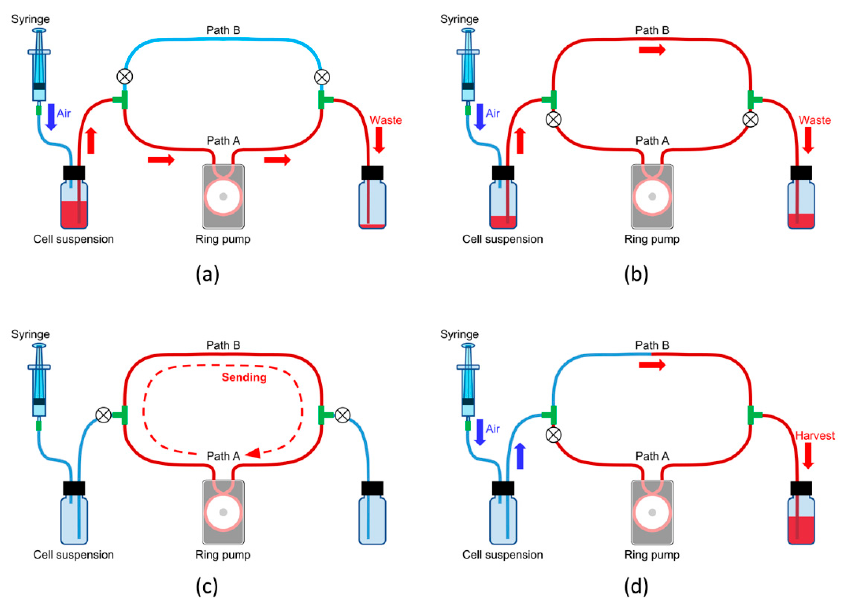
Figure 3. Schematic illustrations of the cell suspension sending system for the s-FRP and s-MRPs (gap